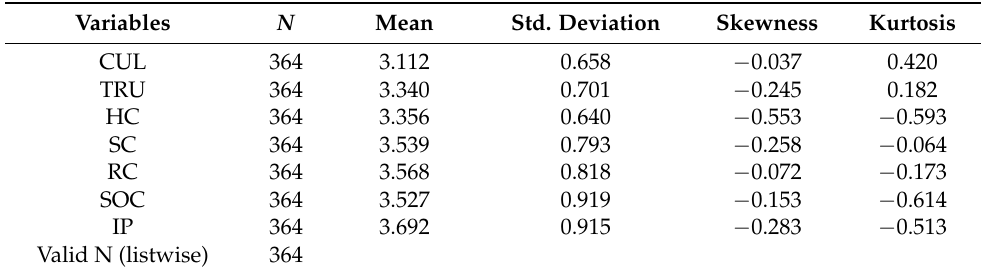
Table 2. Obtained values of multivariate skewness and